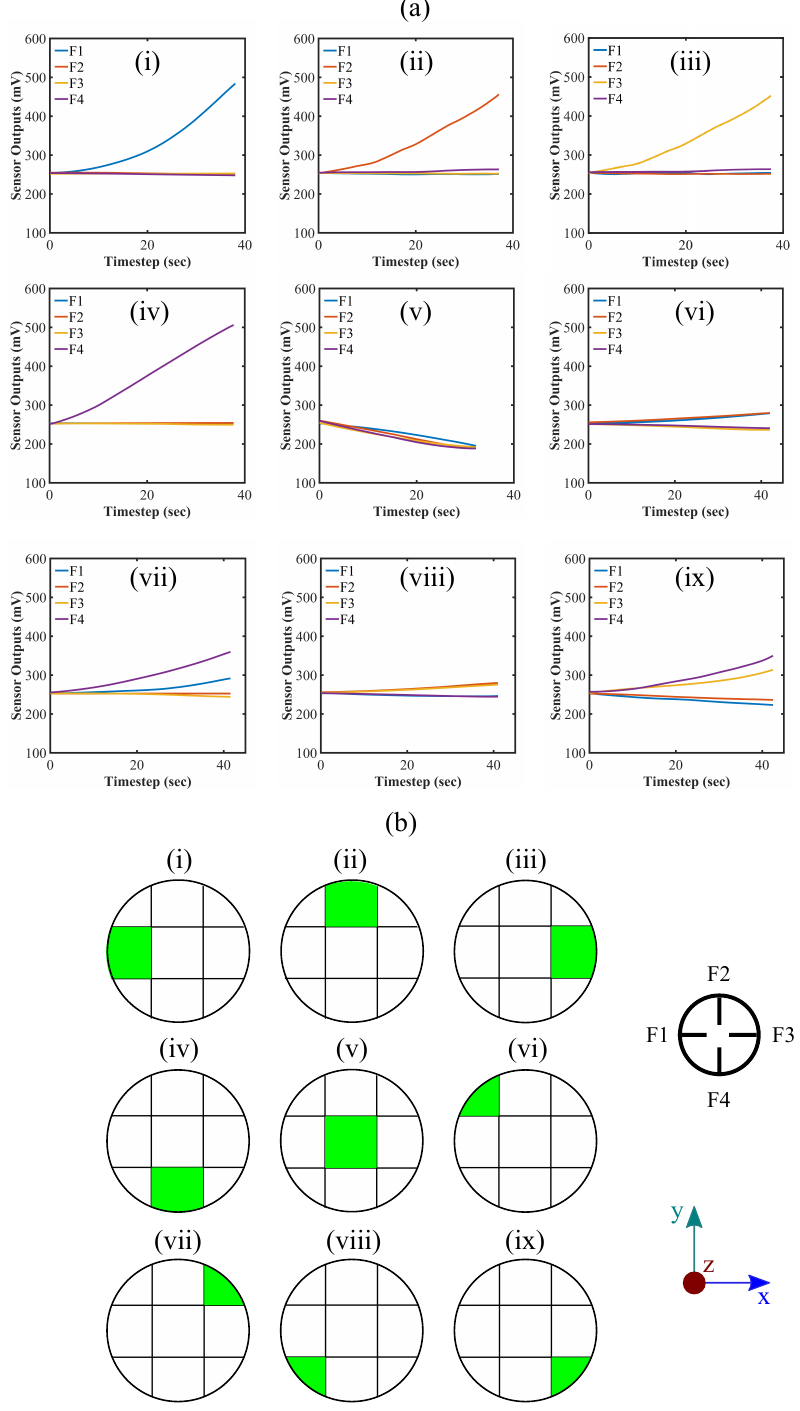
Figure 13. Exerted force location recognition in the grid: ( a ) sensor response due to the applied force and ( b ) corresponding force location generation; top view of the sensor system and coordinate axis are depicted in the lower right